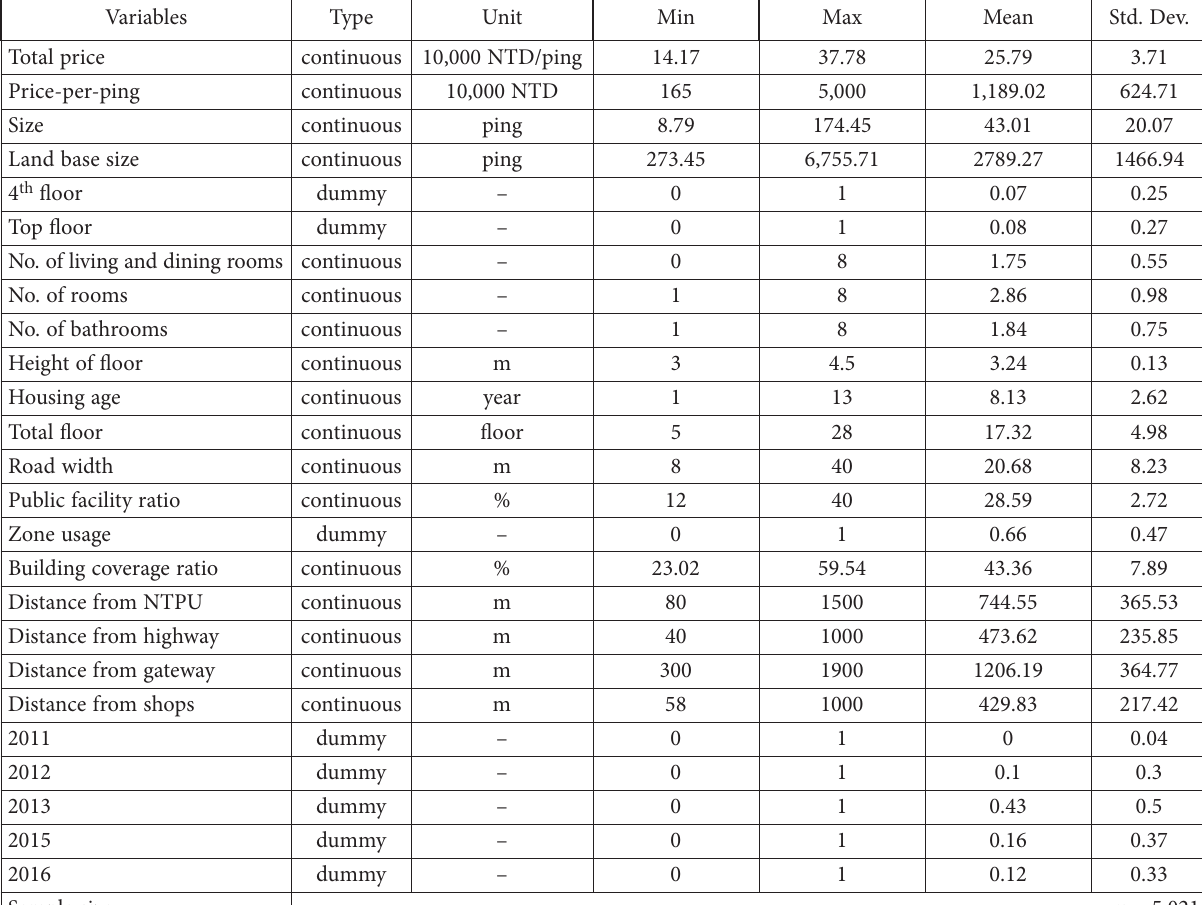
Table 2. Descriptive statistics of housing